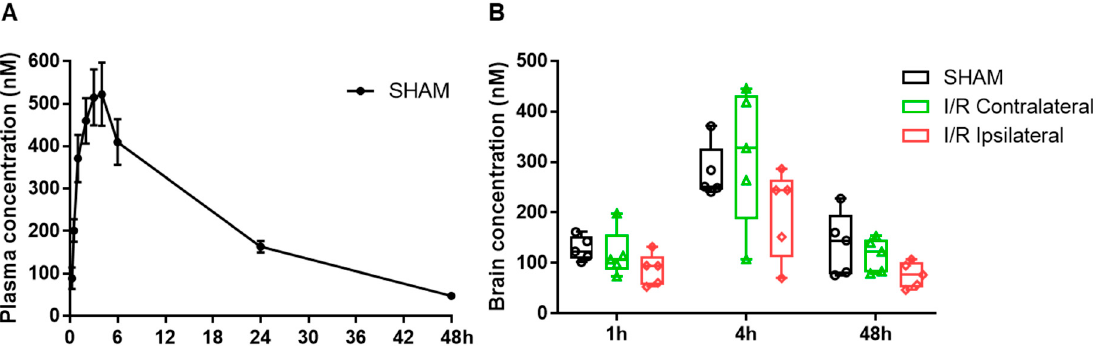
Figure 2. Pharmacokinetics of MF6 in the plasma and brain in sham and I/R mice. ( A ) MF6 plasma concentrations were measured at 0.25, 0.5, 1, 2, 3, 4, 6, 24 and 48 h after MF6 administration in sham mice (n = 5 per group). The data shown in each represent the mean ± SEM. ( B ) The MF6 concentrations in the contralateral and ipsilateral regions of the brains of sham and I/R mice were measured at 1, 4 and 48 h after MF6 administration (n = 5 per group). No statistical difference was observed among the groups at the same time point by one-way analysis of variance (ANOVA) followed by Dunnett’s test.